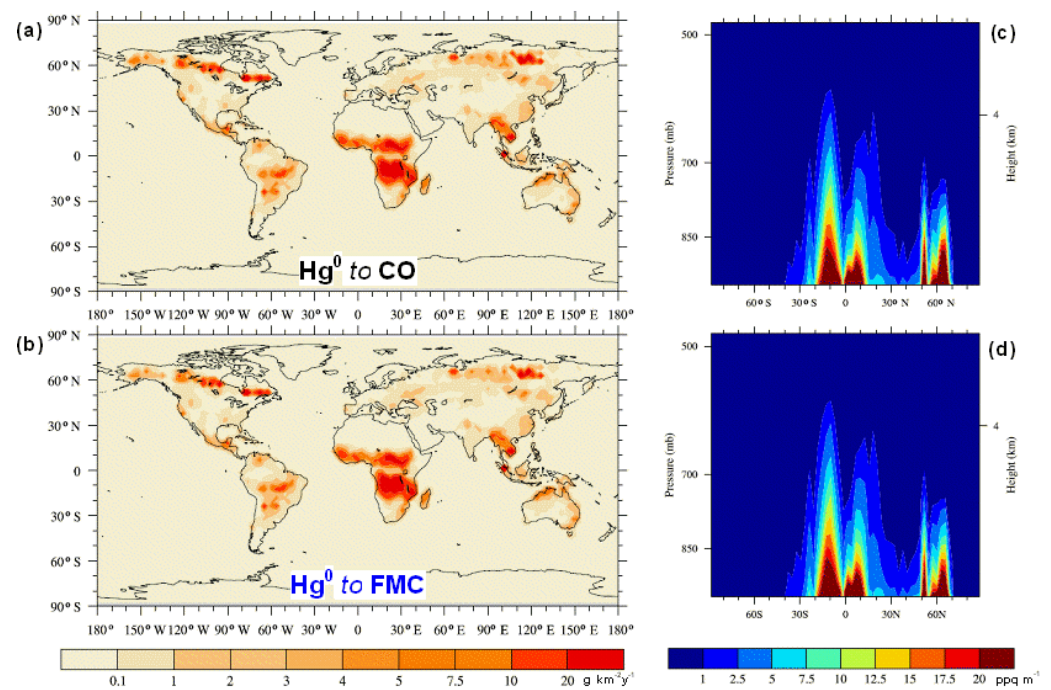
Figure 1. Geographical distribution (a–b) and PBL-type vertical profiles (c–d) of the Hg 0 speciation is determined by FMC (b, d) . For the emissions mapped to CO, only the speciation (15:85 Hg P :Hg 0